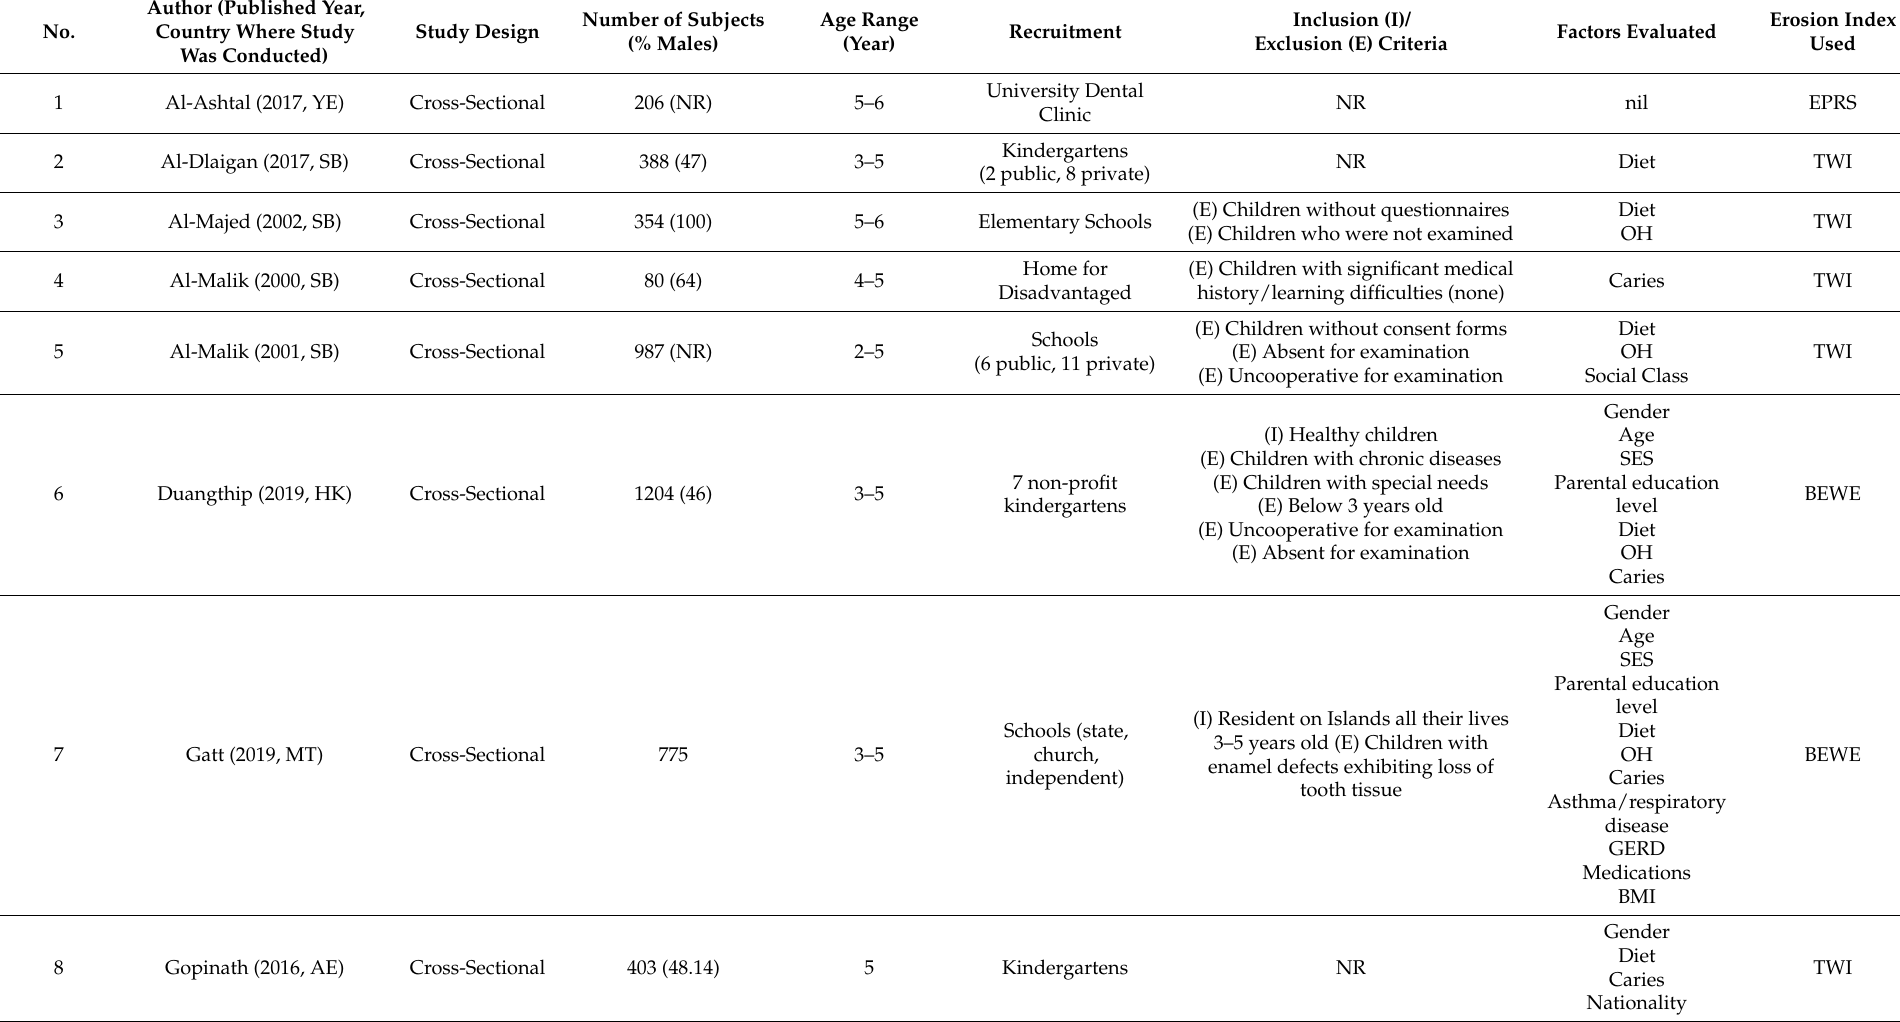
Table 1. Characteristics of included